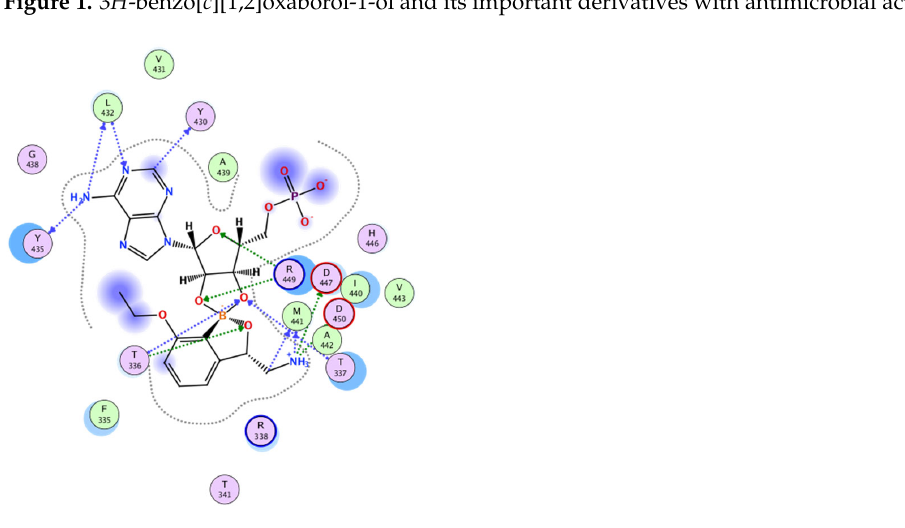
Figure 2. Ligand interaction diagram of Mtb H37Rv LeuRS and ( S ) ‐ 3 ‐ (aminomethyl) ‐ 7 ‐ ethox ‐ ybenzo[c][1,2] ‐ oxaborol ‐ 1( 3H ) ‐ ol in the form of the bivalent adduct with AMP (PDB ID: 5AGR).